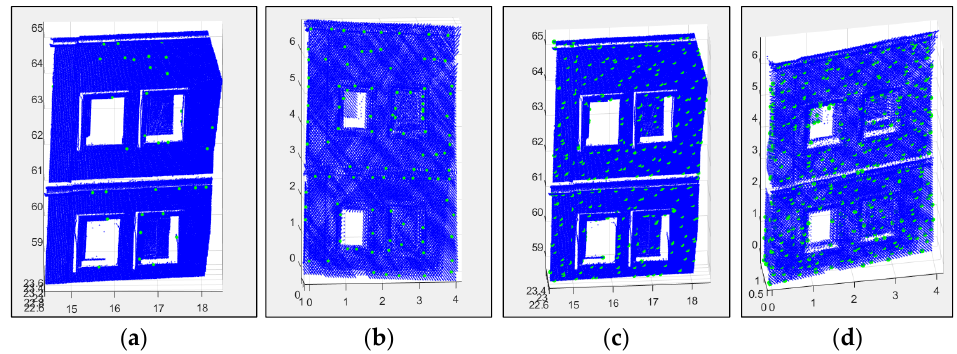
Figure 14. Distribution of the detected keypoints for point cloud datasets for building facade using the following: ( a ) intrinsic shape signatures (ISS) algorithm with TLS data; ( b ) ISS algorithm with MLS data; ( c ) local surface patch (LSP) algorithm with TLS data; ( d ) LSP algorithm with MLS data.